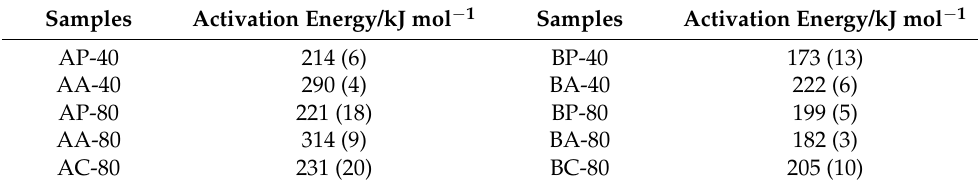
Figure 8. Kissinger linear fitting to determine the activation energy of the crystallization process of the compacted specimens (each experimental point corresponds to peak temperatures measured at 5, 10, 20, and 40 K/min). Activation energy (and its uncertainity) are given in Table 4. Table 4. The activation energy of the main crystallization process in samples A and B.